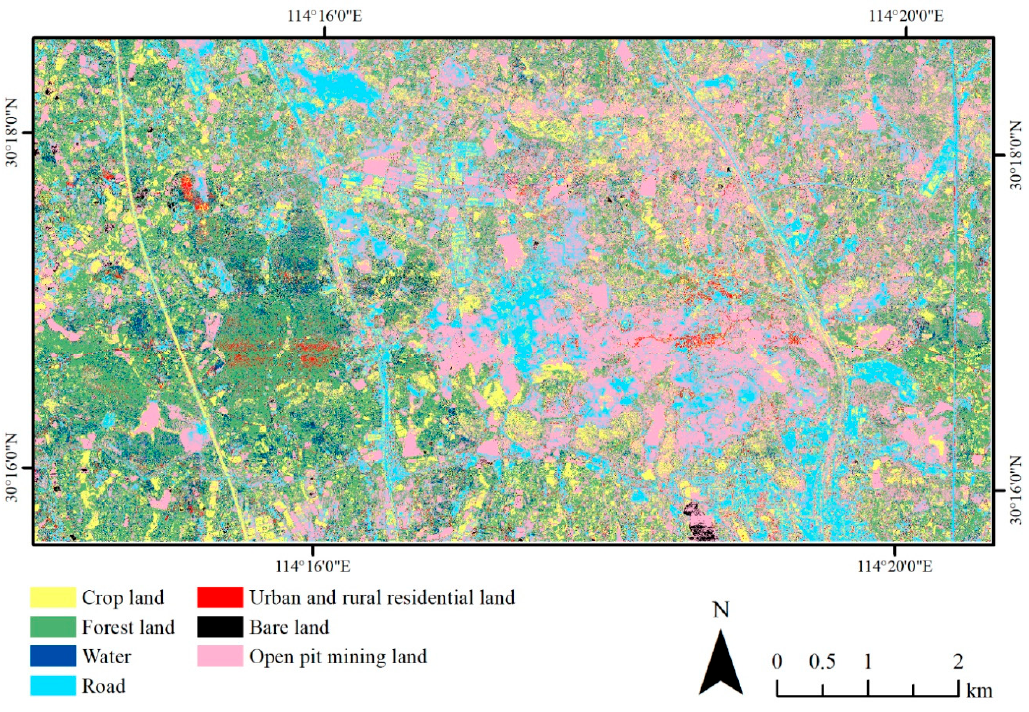
Figure 3. The predicted map of the study area with the first-level land covers. Table 8. Overall accuracies (OAs) of different methods for the independent test set (%). SVM